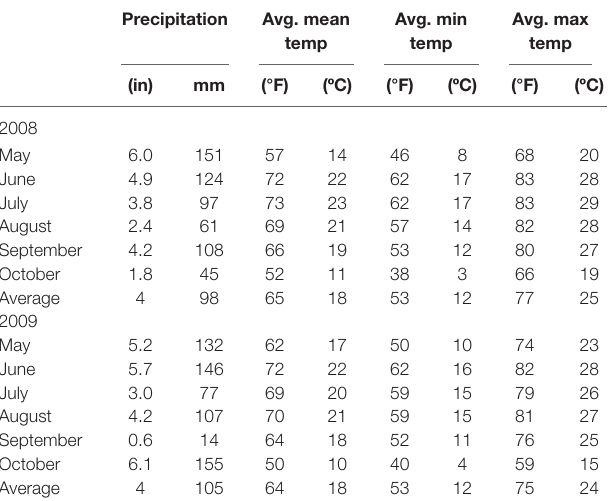
TABLE 1 | Mean air temperature and precipitation at Lafayette IN during the crop season of 2008 and 2009.